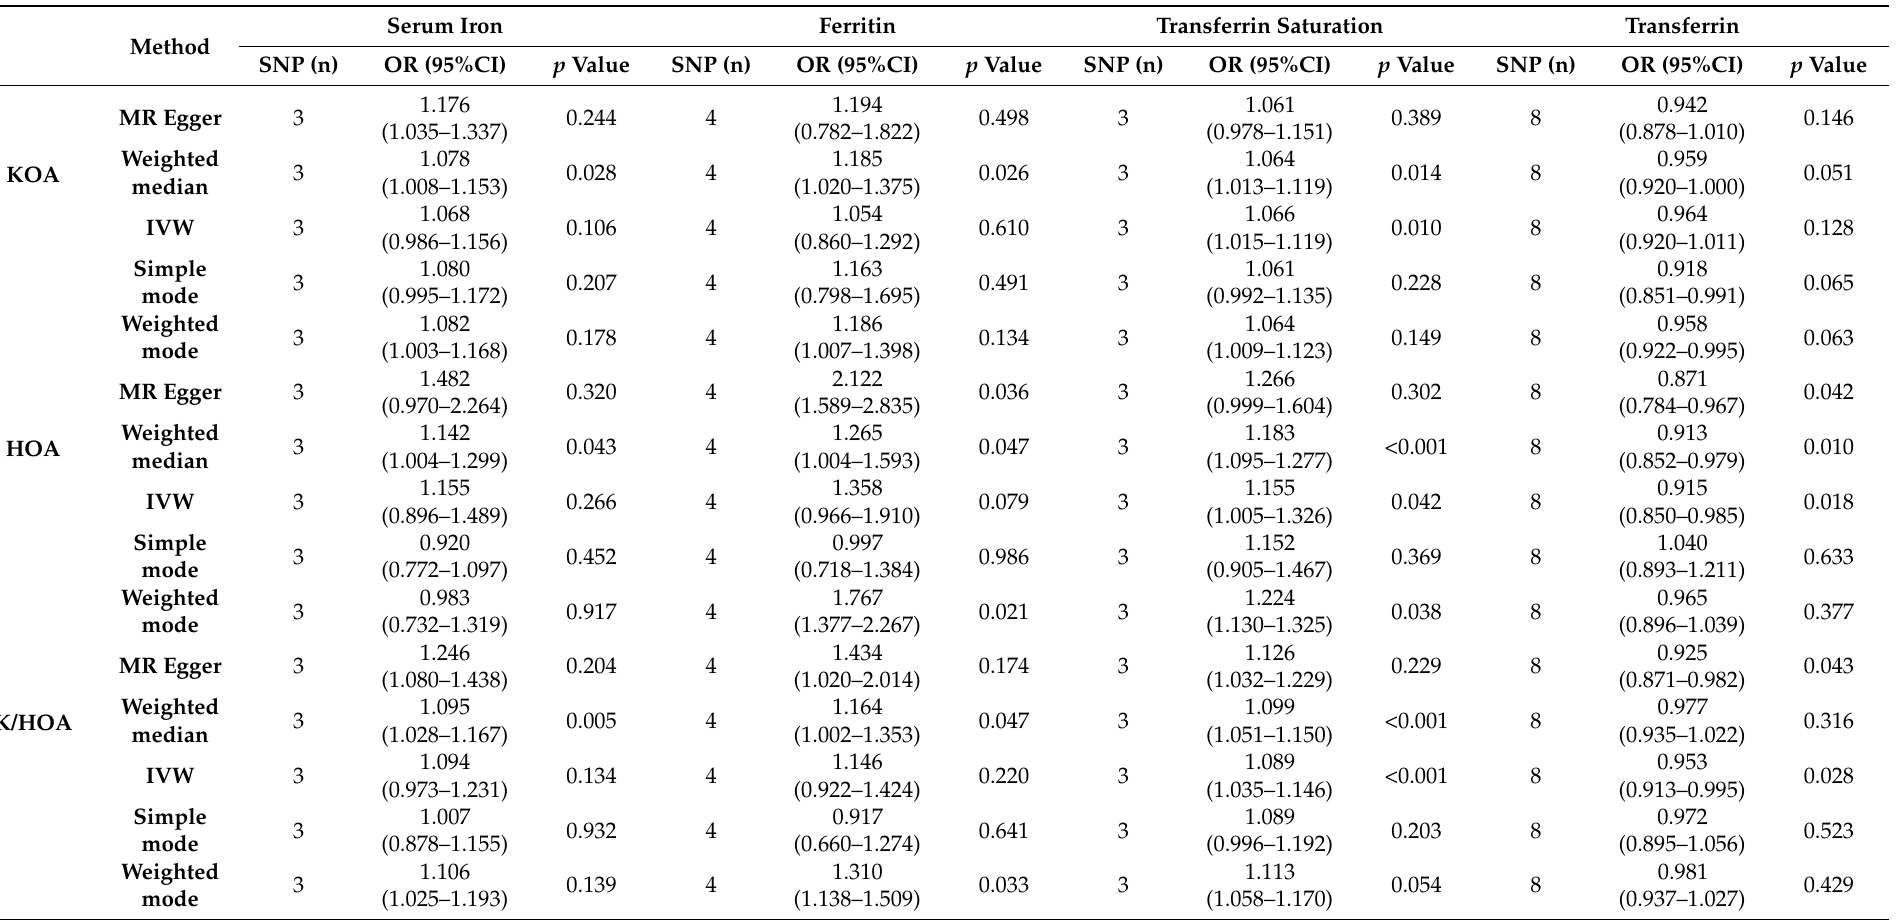
Table 1. Mendelian randomization (MR) analysis of osteoarthritis (OA) and iron status